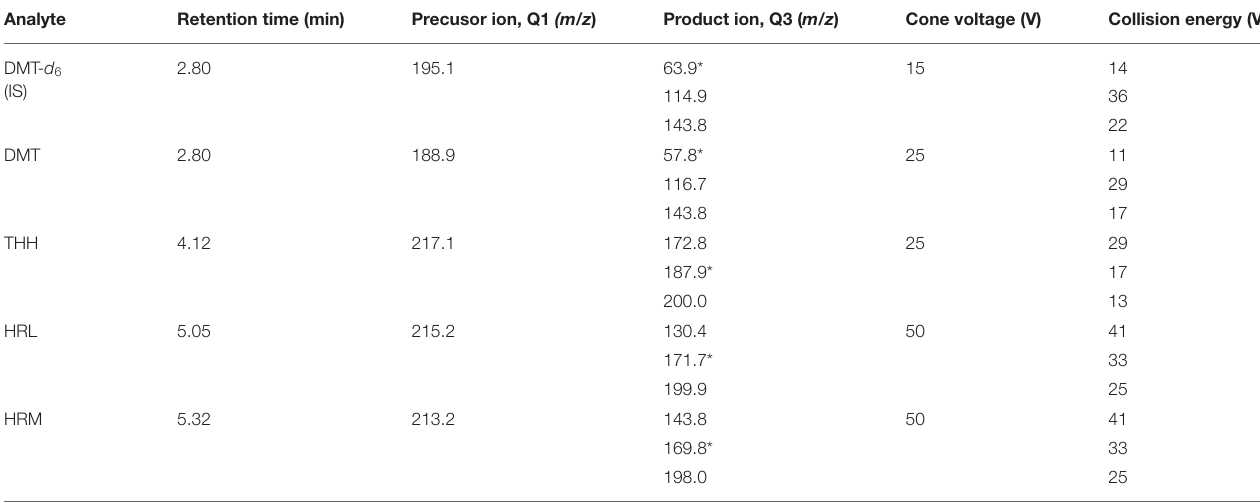
TABLE 1 | Mass spectrometry parameters for all analytes and the internal standard (quantifying transition marked with an asterisk). Analyte Retention time (min) Precusor ion, Q1 (m/z ) Product ion, Q3 ( m/z